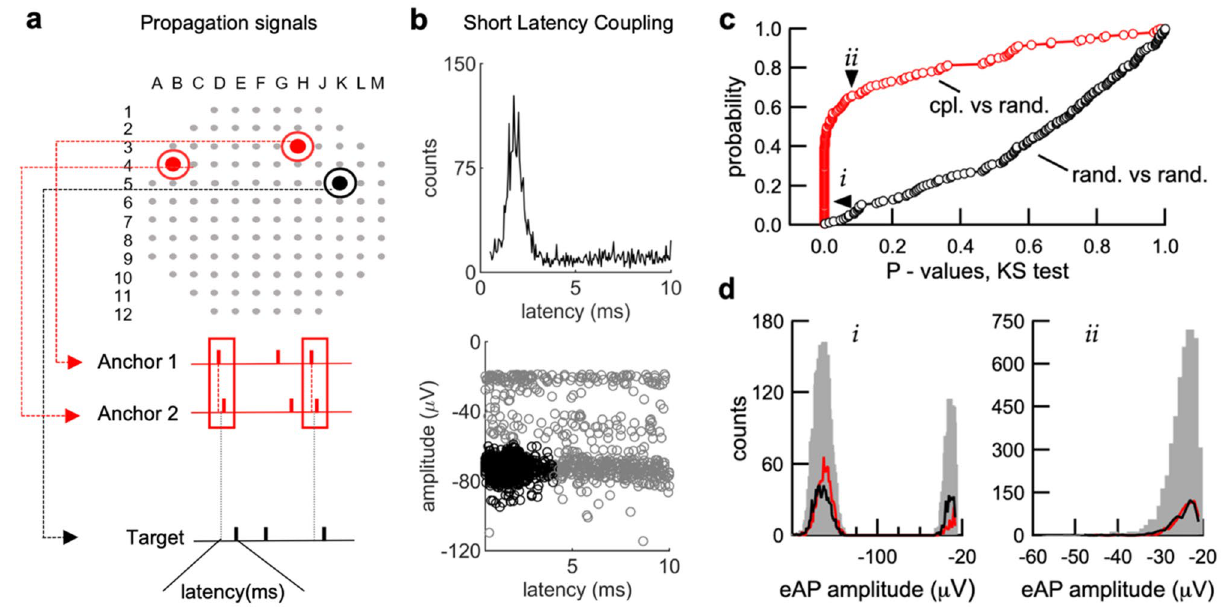
Figure 2. Algorithm for the routine detection of synaptic coupling. ( a ) following propagation signal detection, two electrodes with the most co-occurrences from each propagation signal were picked as anchor points to compute the spike times. ( b ) A CCG is generated and stored using propagation signal spike times as a reference and all other individual electrodes as targets. To inspect the specificity of the postsynaptic response, a scatter plot of spike amplitude versus spike latency in the target electrode is produced. A few criteria can be used for deciding the existence of a short latency connection including: 1) The position of the peak of the CCGs, 2) the standard deviation of the latency and amplitude, 3) the proportion of spikes that fall into the peak region, and 4) the ratio of the number of spikes in the peak region to the number of spikes in the reference signal. The specific values for the criteria can alternatively be user defined. ( c , d ) (right) The two-sample KS test (two-sided) P value distribution of coupled-versus-coupled comparisons (red circles) and random-versus-random comparisons (black circles). The amplitude distributions of some electrodes are expected to be unimodal if eAPs from only single neurons are detected by those electrodes. In these cases, coupled spikes would be expected to have the same amplitude distribution as randomly selected spikes, as is the case for comparisons that do not